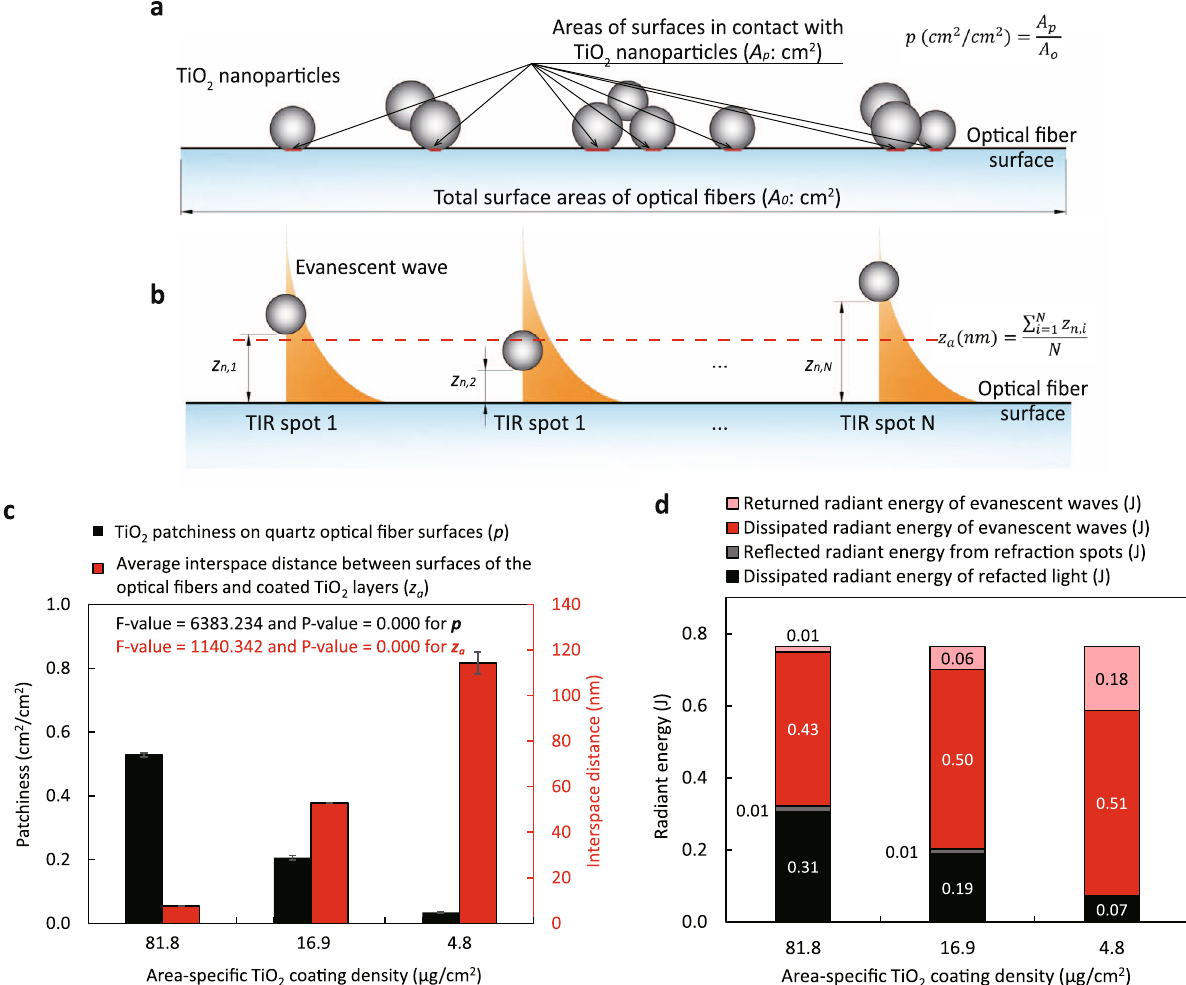
Fig. 4 Modeling results of light propagation in the three TiO 2 -QOFs. a Schematic showing TiO 2 patchiness on quartz optical fi bers ( p ); b schematic showing average interspace distance between fi ber surfaces and TiO 2 coating layers ( z a ); c TiO 2 coating layer structure parameters ( p and z a ) of the three TiO 2 -QOFs; and d modeling results of the dissipated radiant energy of evanescent waves ( E E ; dis 0 ) and refracted light ( E R ; dis 0 ) as well as the returned radiant energy of evanescent waves ( E E,return ) and the re fl ected radiant energy from refraction spots ( E R,re fl ect ) in the three TiO 2 -QOFs (conditions: light intensity = 7.02 mW/cm 2 , wavelength = 365 nm, TiO 2 coating length = 6.5 cm, irradiation duration = 4